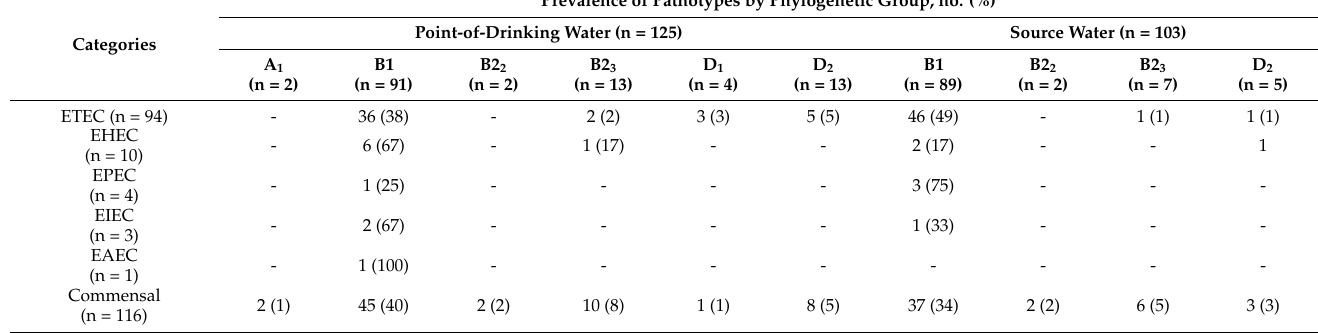
Table 3. Phylogenetic and subgrouping distribution of pathotypes and commensal E. coli strains. Distribution was sought for 228 isolates from the point-of-drinking water and the source water in Arichpur, Dhaka, collected